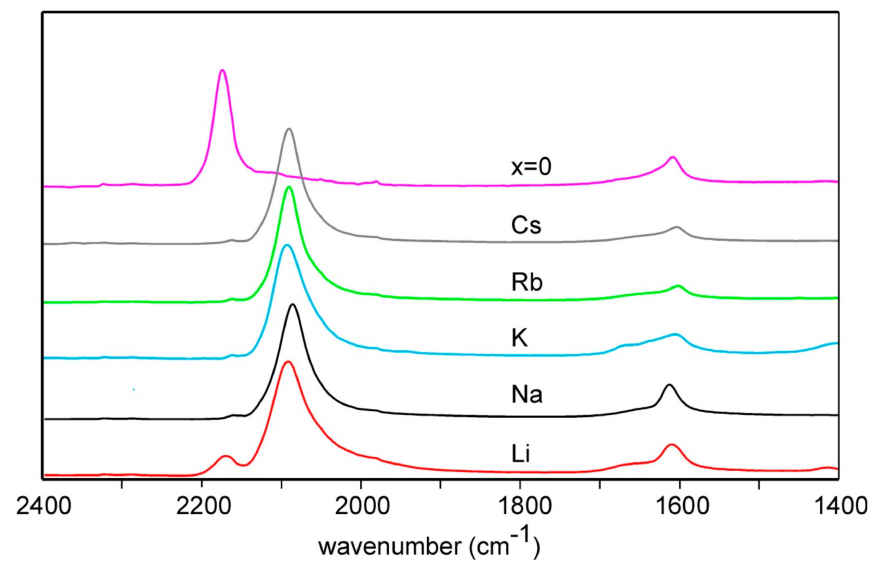
Figure 3. IR spectra of A 2 / 3 Cu[Fe(CN) 6 ] 2 / 3 compounds with A = Li, Na, K, Rb and Cs, and the nominally alkaline-free compound x = 0. The band at ~1600 cm − 1 is from bending vibrations from H 2 O and the bands at ~2093 cm − 1 and ~2178 cm -1 correspond to C–N vibrations in Fe 3 + –CN–Cu 2 + and Fe 2 + –CN–Cu 2 + , respectively.